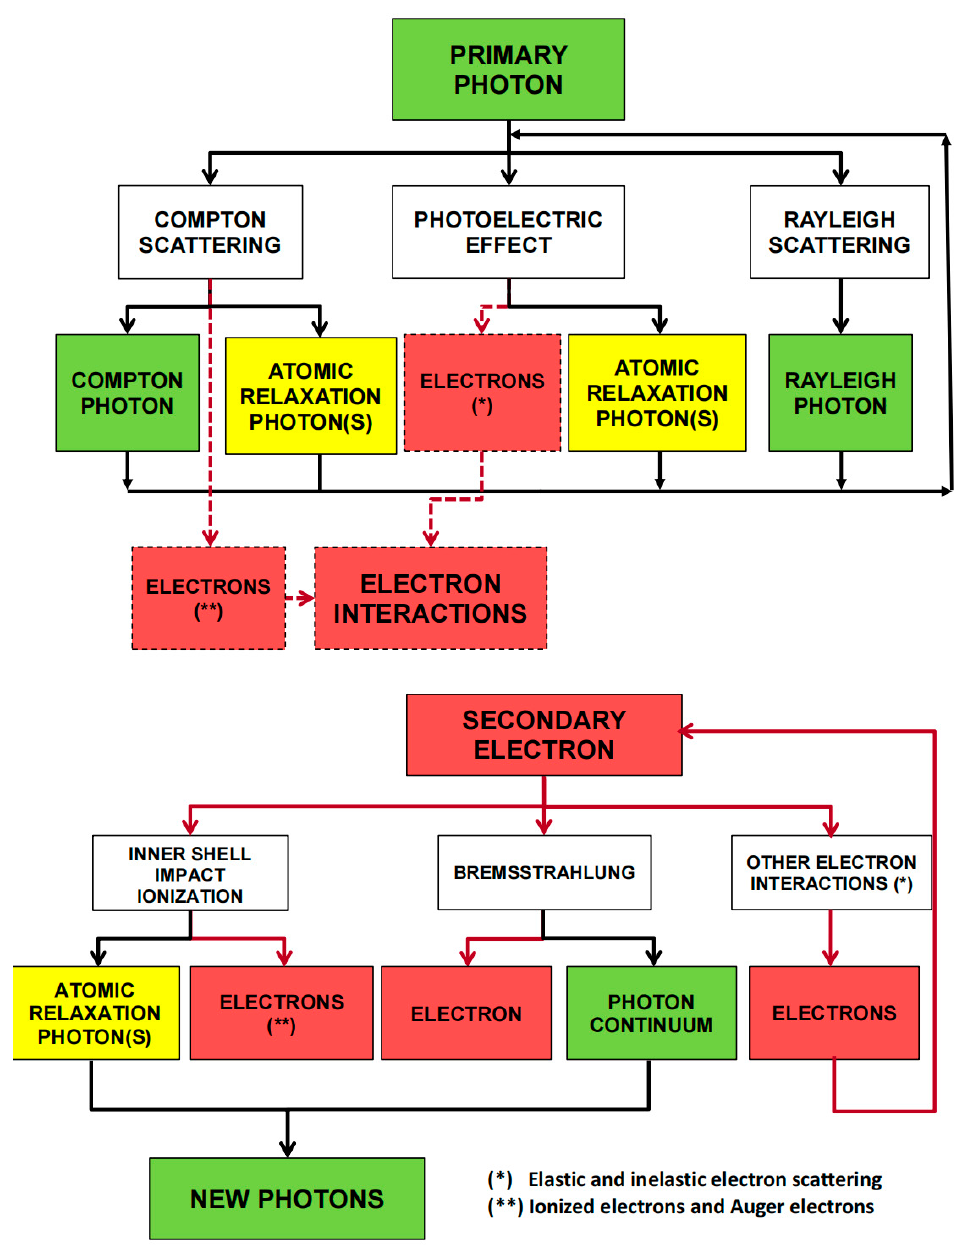
Figure 1. Main photon interactions in the energy range 1–150 keV. Photons are represented with green boxes and solid lines, and electrons with red boxes and dashed lines. Interactions are shown in white boxes. The contributions to the characteristic X-ray line are indicated with yellow boxes. It is worth noting that one of them is a consequence of electron–photon coupling. Photon contributions following interactions involving secondary electrons are considered in the lower scheme, which is specific to the coupling. The self-enhancement process is not indicated in this scheme.